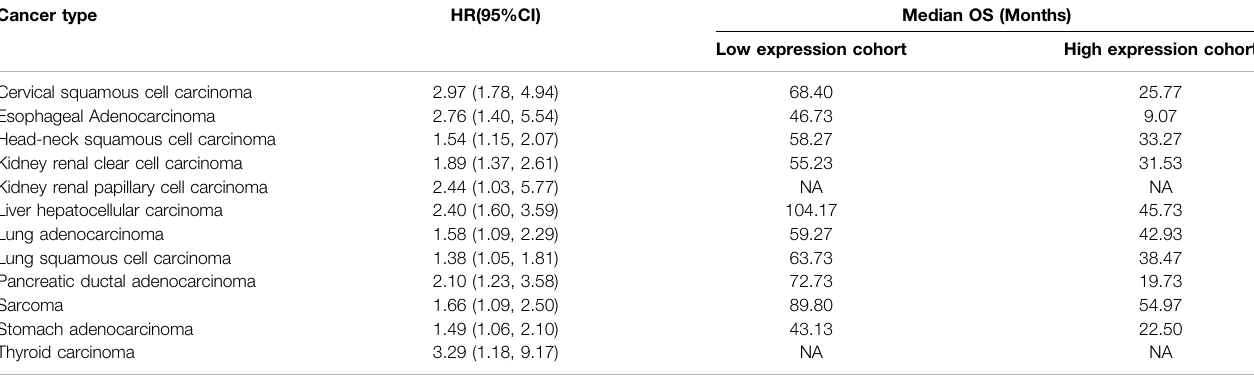
TABLE 3 | The correlation between CXCL8 expression and cancer survival in TCGA cohorts. HR, hazard ratio; CI, con fi dence interval; OS, overall survival; NA, not analysis. Cancer type